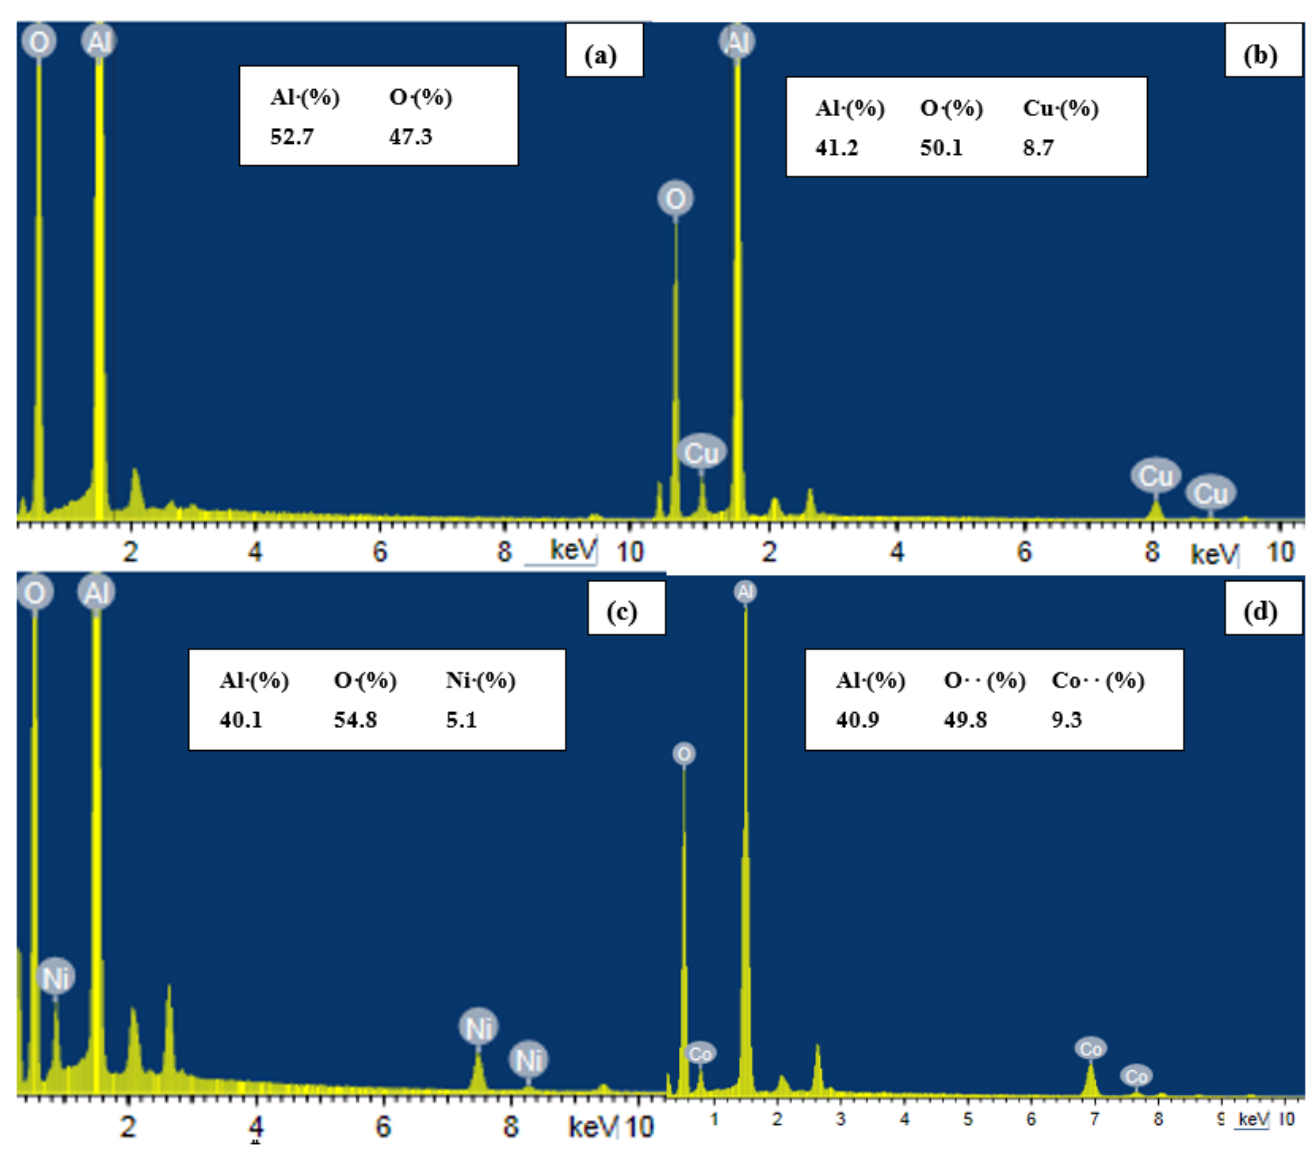
Figure 2. EDX results of the prepared ( a ) Al 2 O 3 nanoparticles, ( b – d ) Al 2 O 3 doped by CuO, NiO, and CoO, respectively.